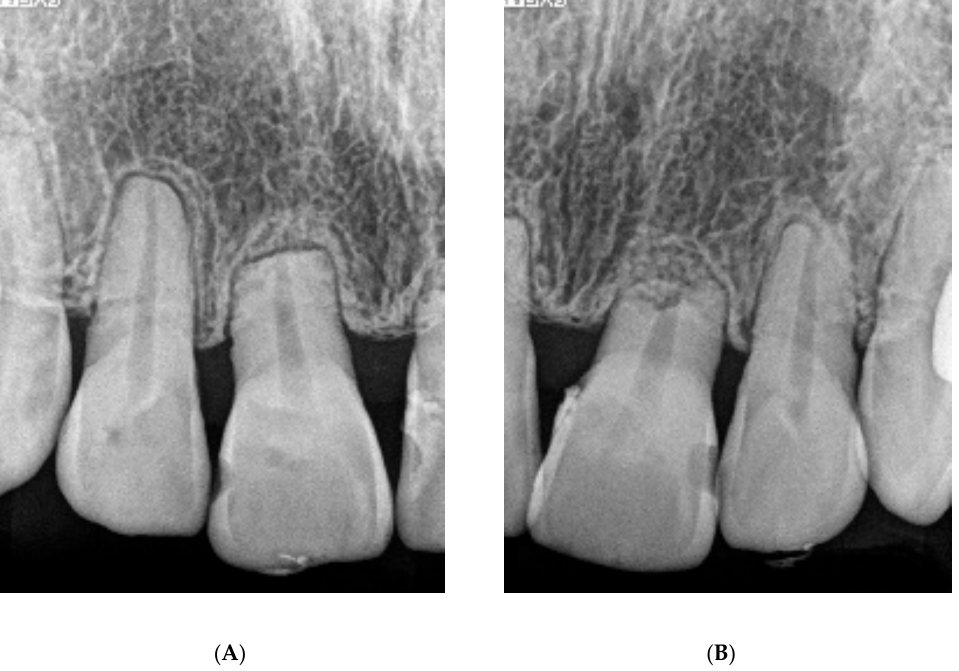
Figure 3. The dental radiograph of severe root resorption of Figure 2D ( A ): Right side, ( B ): Left side).